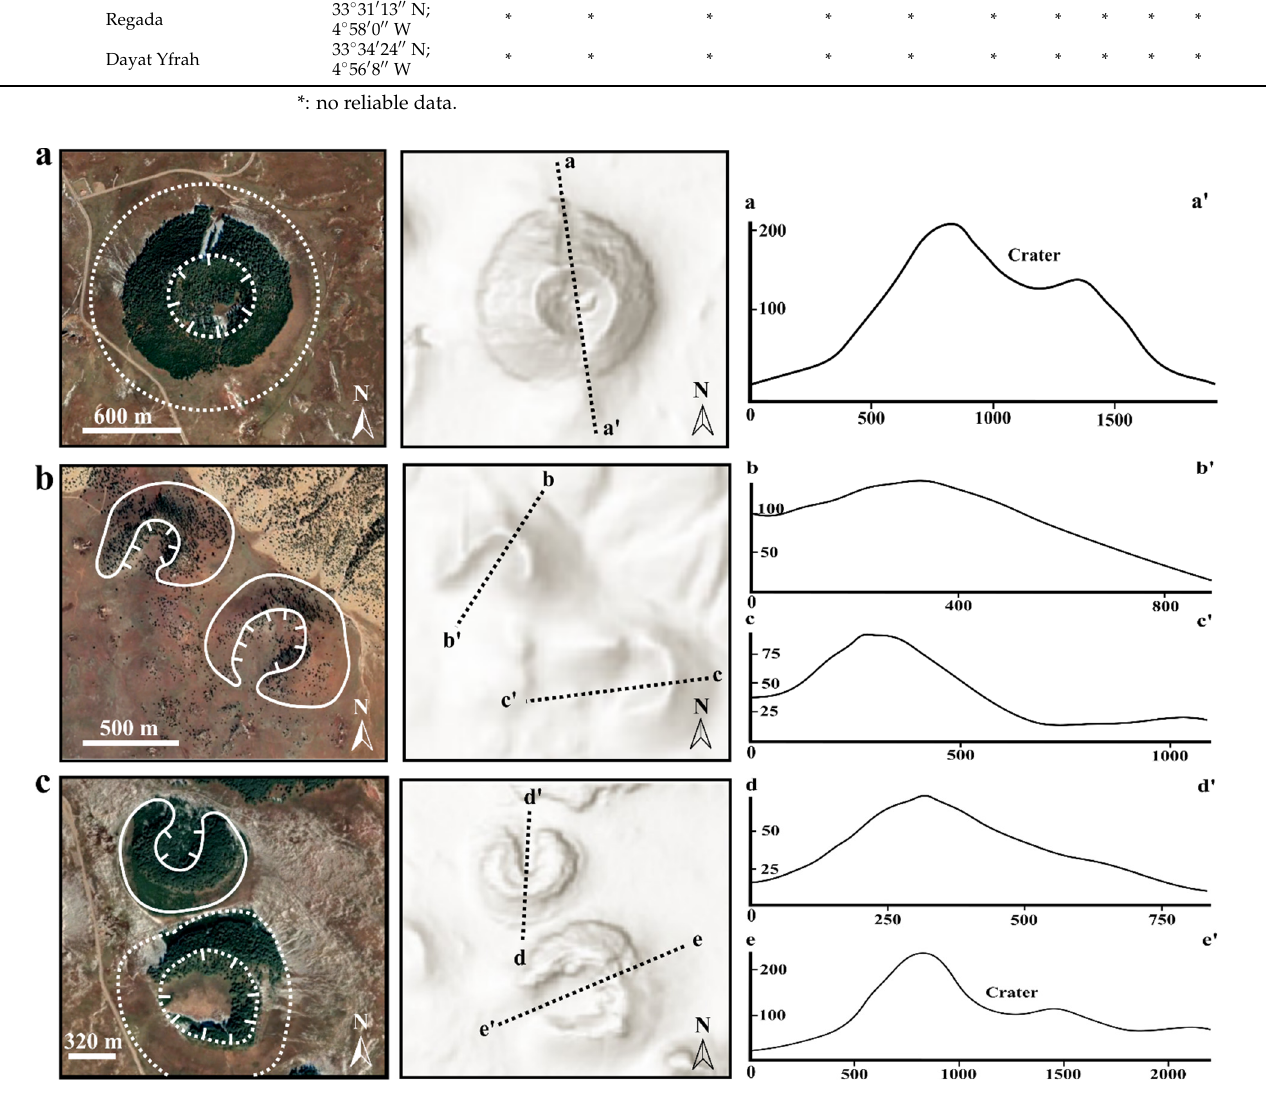
Figure 4. Google Earth satellite photos, digital terrain models, and associated topographic profiles along the dotted lines for scoria cones: ( a ) Hebri (33° 21 ′ 35 ′′ N; 5° 8 ′ 26 ′′ W); ( b ) Selrhert (S 1 and 2) (33° 10 ′ 33 ′′ N; 4° 59 ′ 35 ′′ W and 33° 10 ′ 51 ′′ N; 4° 59 ′ 56 ′′ W); ( c ) Habri (33° 23 ′ 00 ′′ N; 5° 9 ′ 24 ′′ W), Tizi Idguel (33° 23 ′ 35 ′′ N; 5° 9 ′ 33 ′′ W).